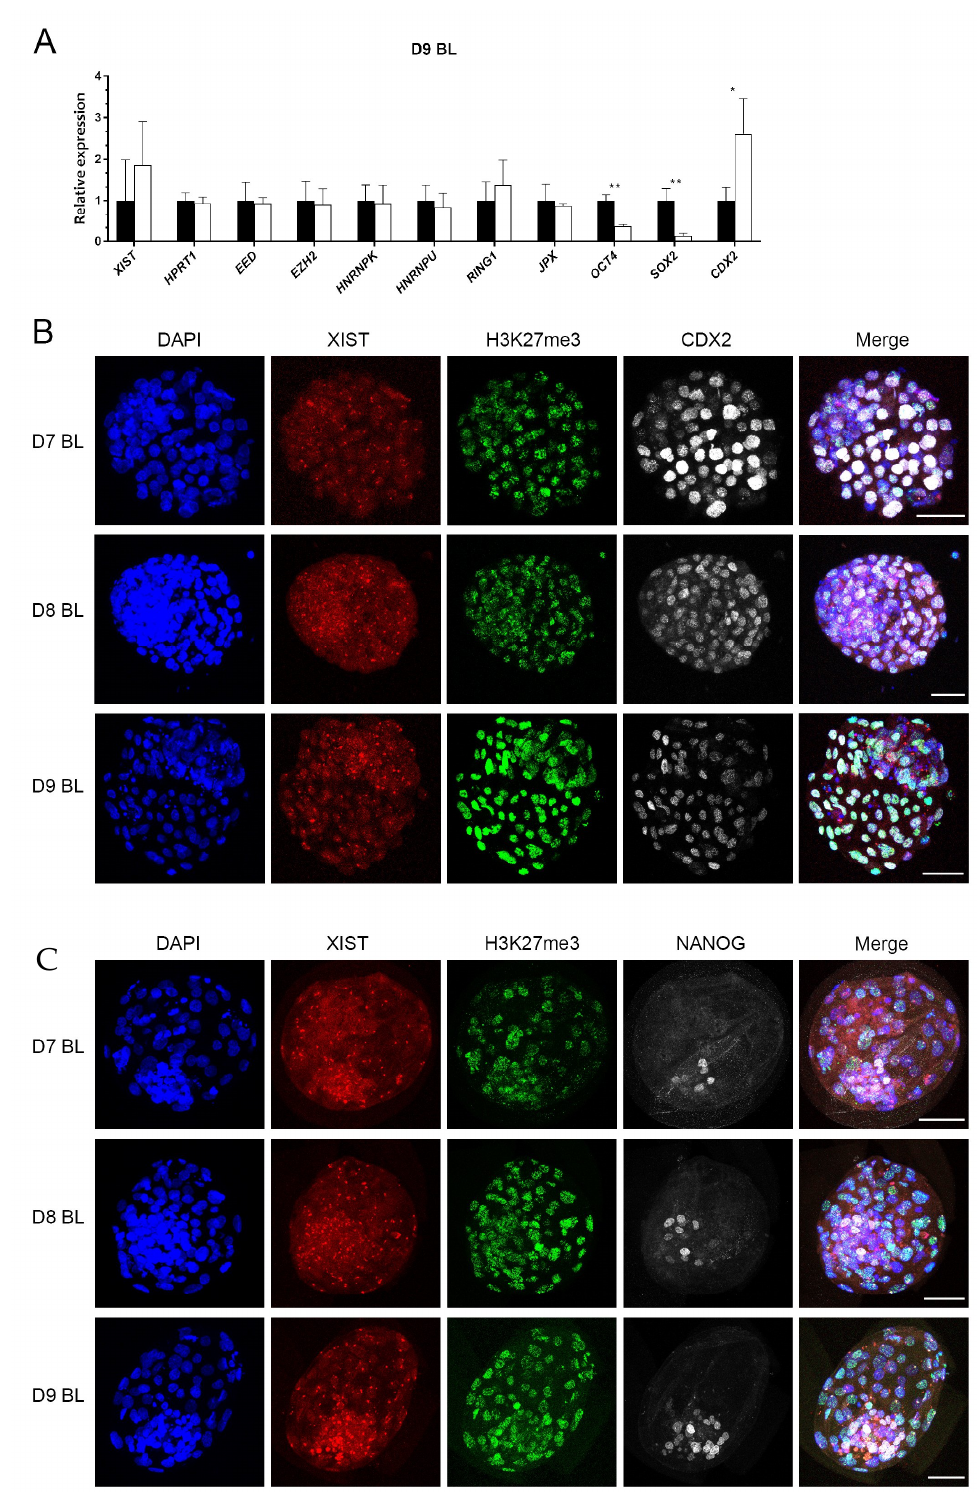
Figure 4. The relative expression of XCI related genes in inner cell mass (ICM) cells (black bars) and trophectoderm (TE) cells (white bars), and XIST RNA FISH combined with immunofluorescence in female embryos. The relative expression of XCI related genes ( A ). Relative expression in ICM set at 1; * ( p < 0.05) and ** ( p < 0.05) indicate significant di ff erences. Error bars indicate standard deviations of three biological replicates. XIST RNA FISH combined with double staining of H3K27me3 and CDX2 ( B ) or NANOG ( C ) from day 7 (D7) to day 9 (D9) blastocysts, scale bar = 50 µ m. BL =